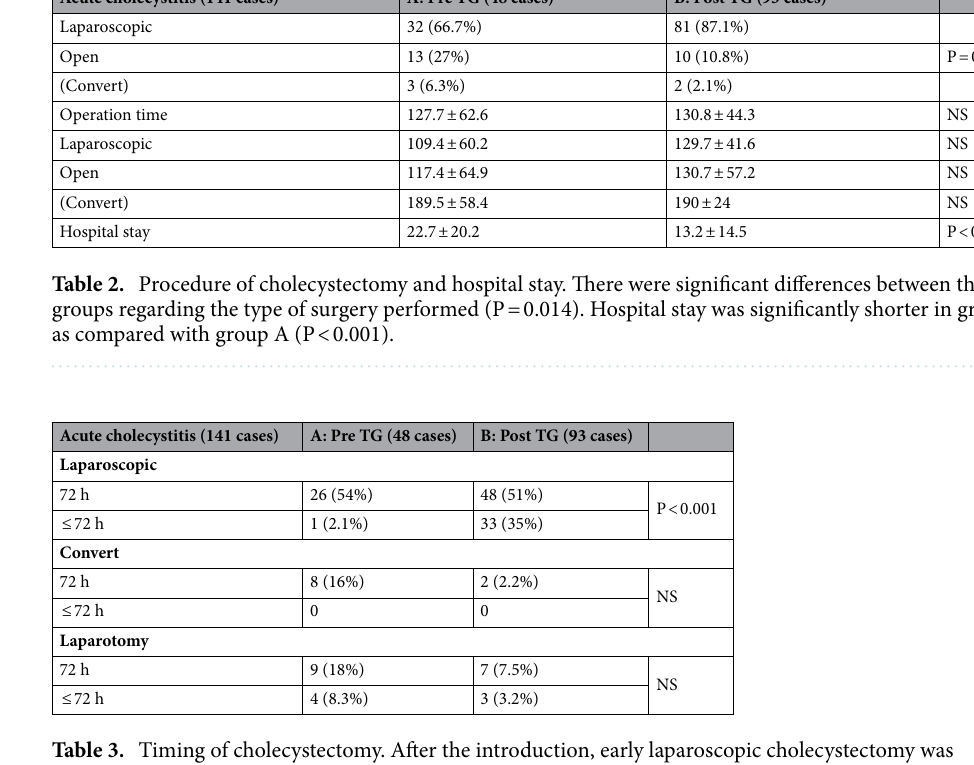
Table 3. Timing of cholecystectomy. After the introduction, early laparoscopic cholecystectomy was significantly increased (P < 0.001). However, the rate of early operations was still 38.7% only.